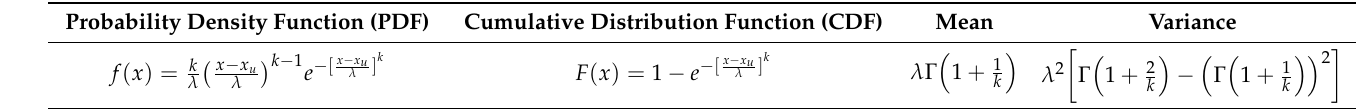
Table 1. Weibull distribution functions and